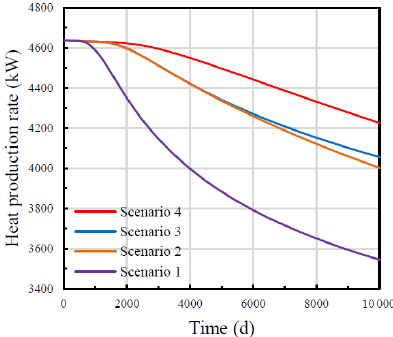
Figure 10. Reservoir heat production rates variation with time for the four modelling